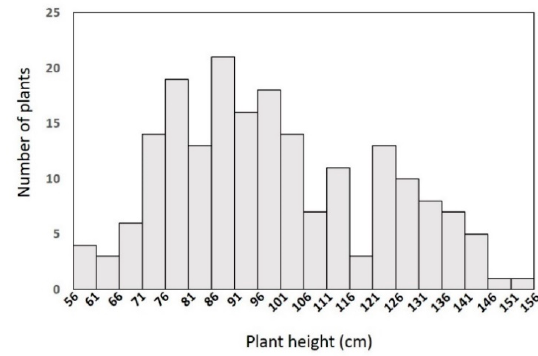
Figure 2. Plant height in YA2016-12 × G184-189 F 2 population. Table 1. Plant height (cm) of dwarf parental line YA2016-12, tall parental line G184-189, and individuals in the F 2 population (mean ± SD). Three replicates were conducted.